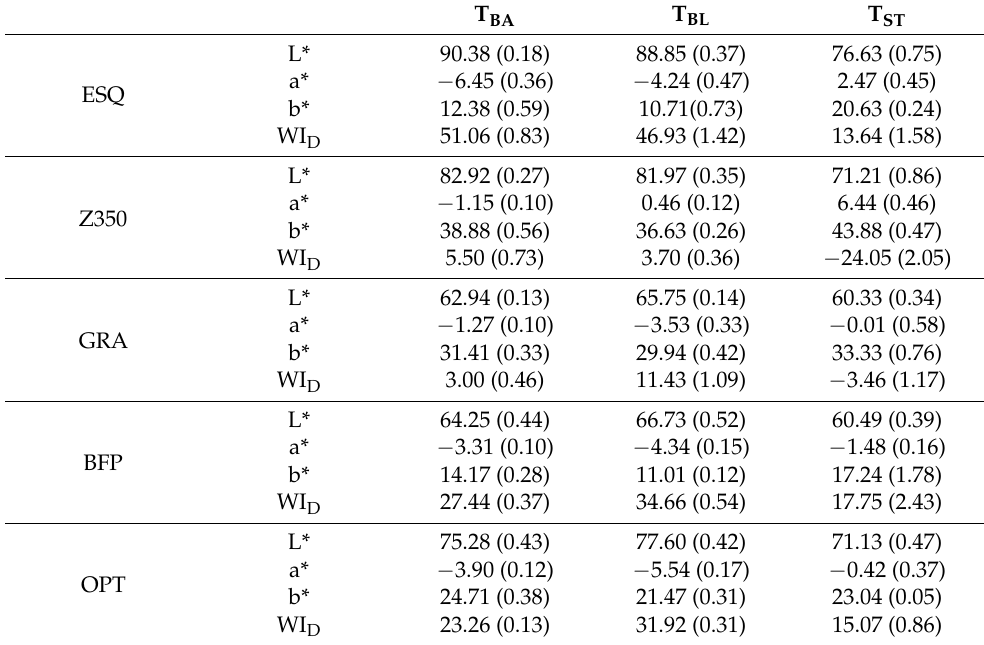
Table 2. Mean (standard deviation) of color parameters in CIELAB system and whiteness index (WI D ) for specimens of each material in bleaching group before (T BA ) and after bleaching procedure (T BL ) and staining treatment (T ST ) from BLE